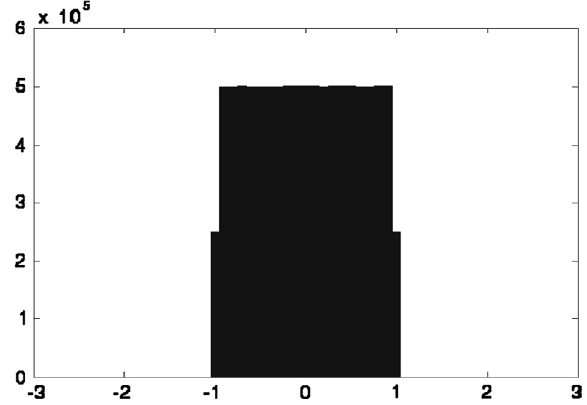
Figure 2. Uniformly distributed random number between –1 and 1 for 1e7 random